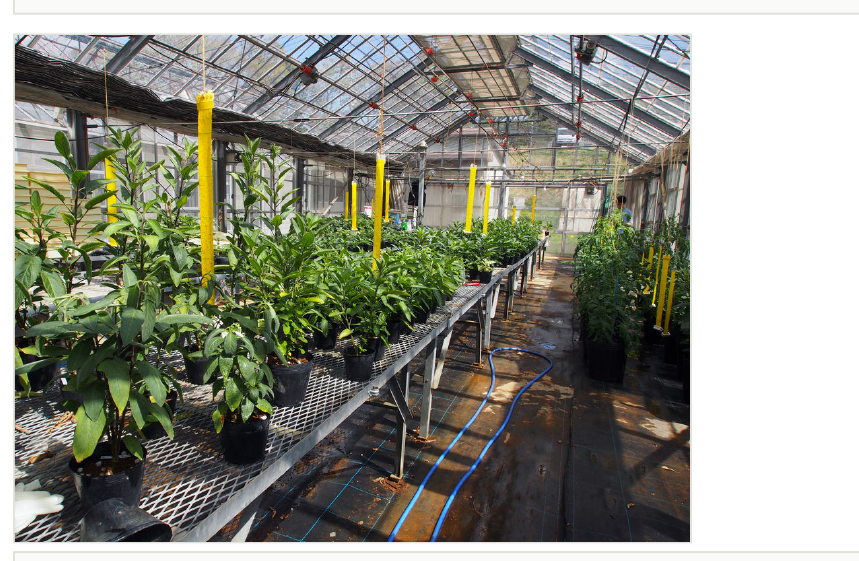
A greenhouse, one of the survey plots in the Atsugi Campus of Tokyo University of Agriculture (TUA), indicated as Plot C in Fig.